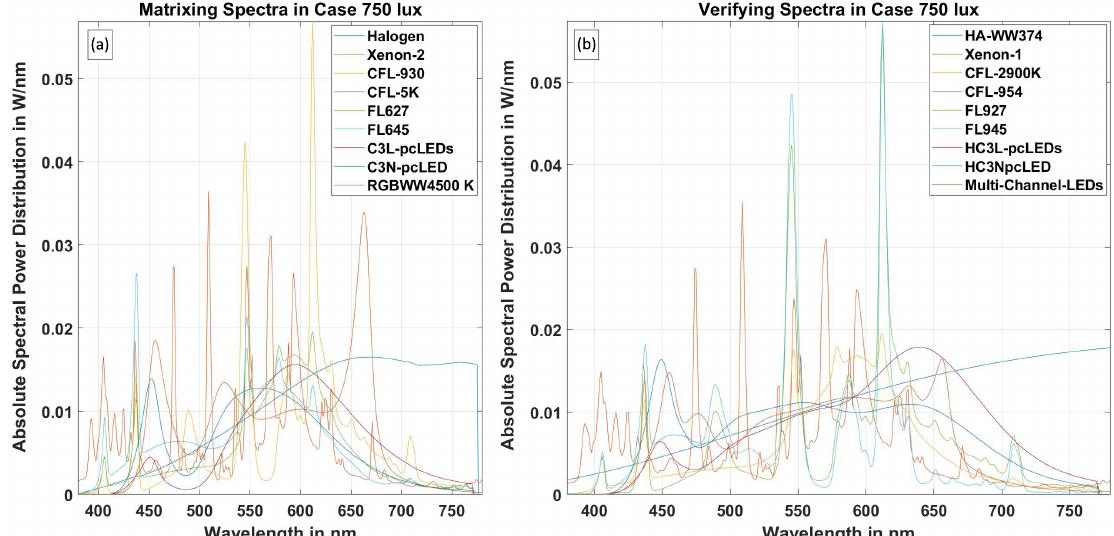
Figure 9. Selection of artificial light sources used in this work ( a ) for determining the RGB to XYZ transformation matrix and ( b ) for model validation.